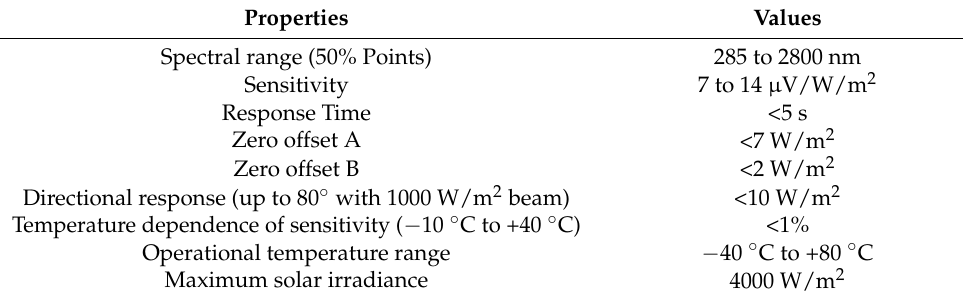
Figure 2. Kipp & Zonen CMP10 pyranometer installed at UET Peshawar. Table 1. Specifications of Kipp & Zonen CMP10